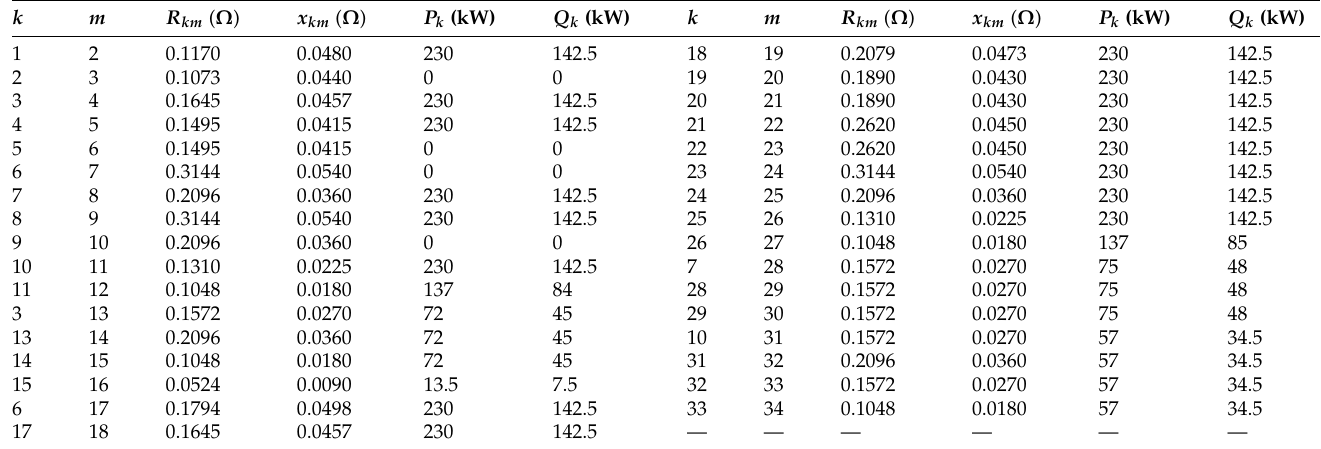
Table 1. IEEE 34-node test feeder